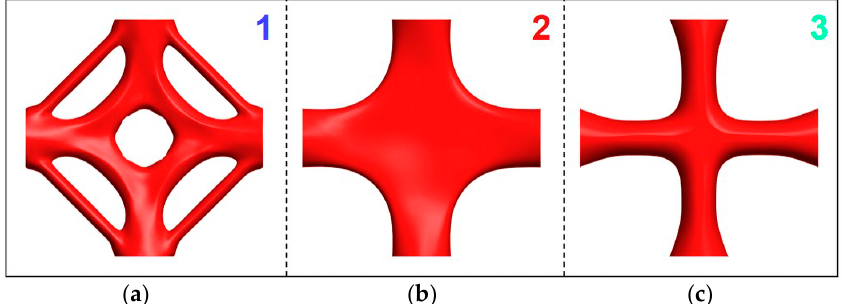
Figure 6. The details of representative generative joints: ( a ) generative joint 1, ( b ) generative joint 2, ( c ) generative joint 3.